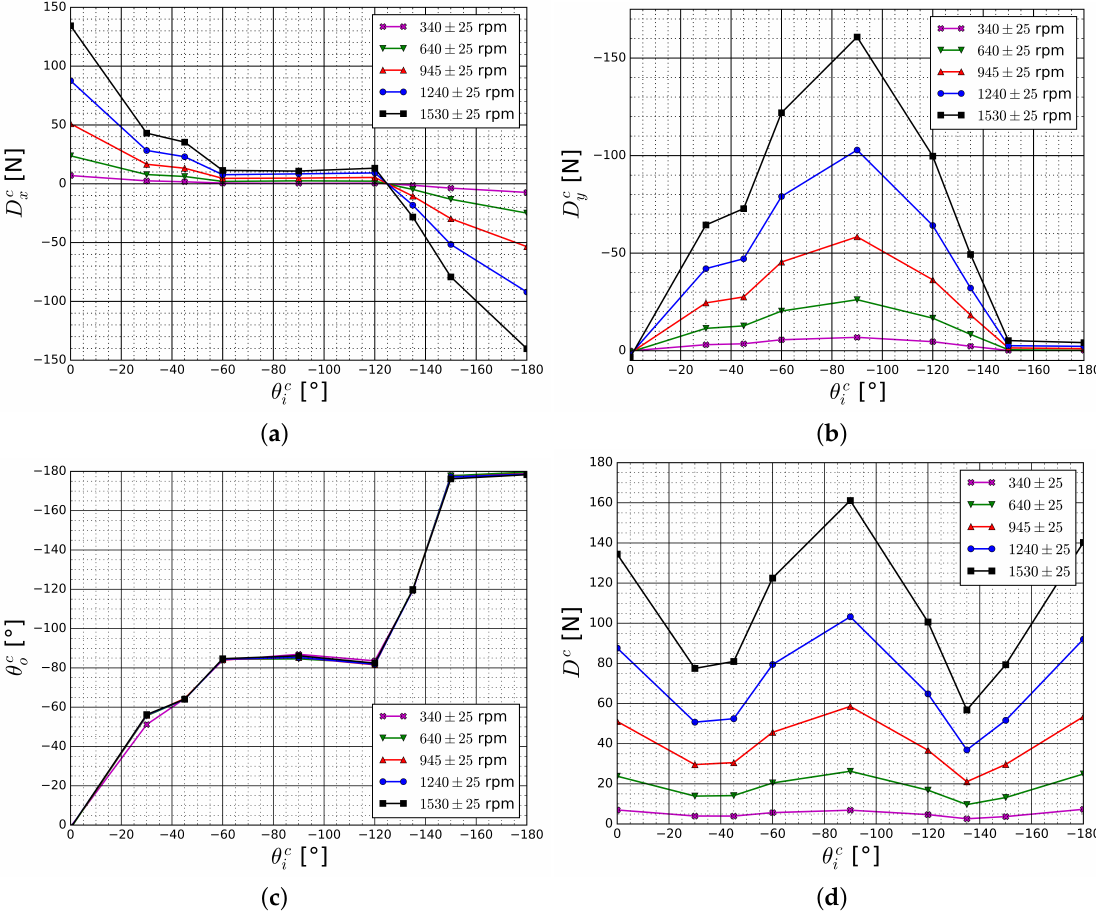
∈ [ 0, − 180 ] °: ( a ) longitudinal i and θ c o , and ( d ) D c , i